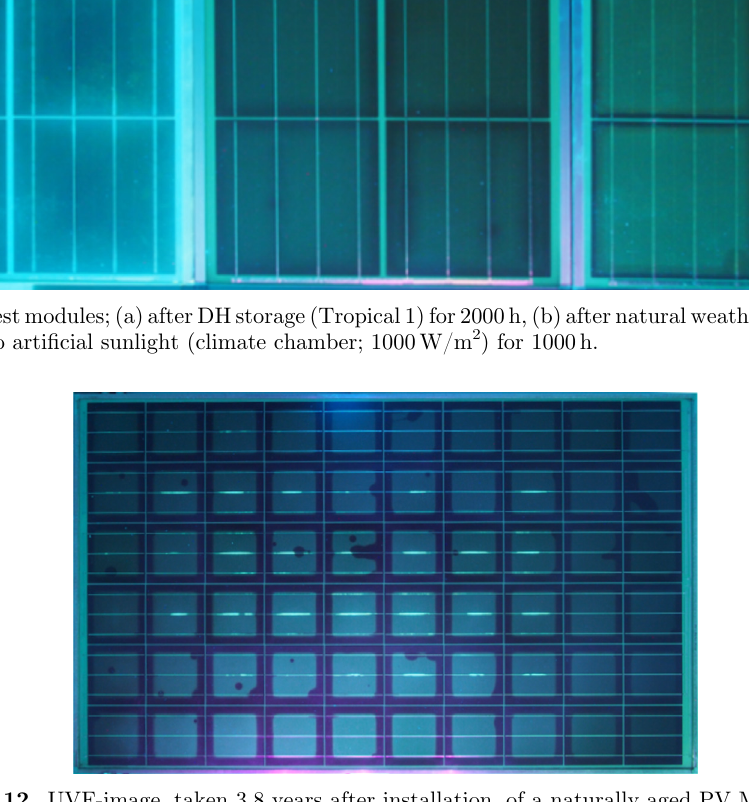
Fig. 12. UVF-image, taken 3.8 years after installation, of a naturally aged PV Module.